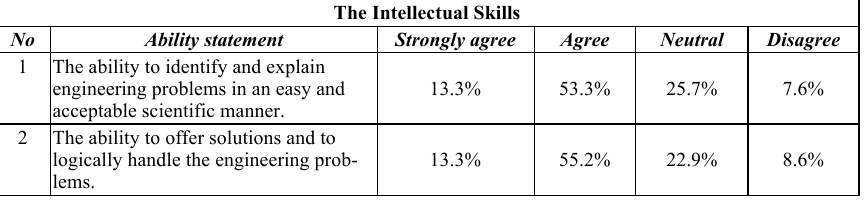
Table 2. Graduates feedback on Intellectual Skills learning